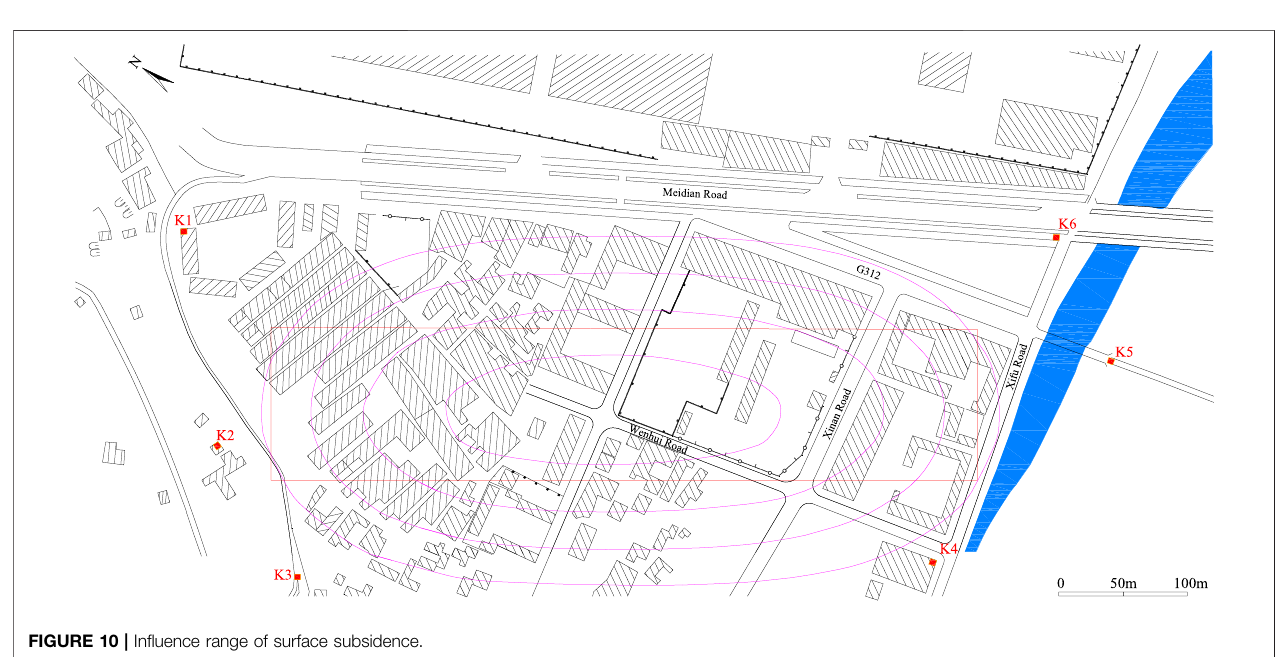
FIGURE 10 | In fl uence range of surface